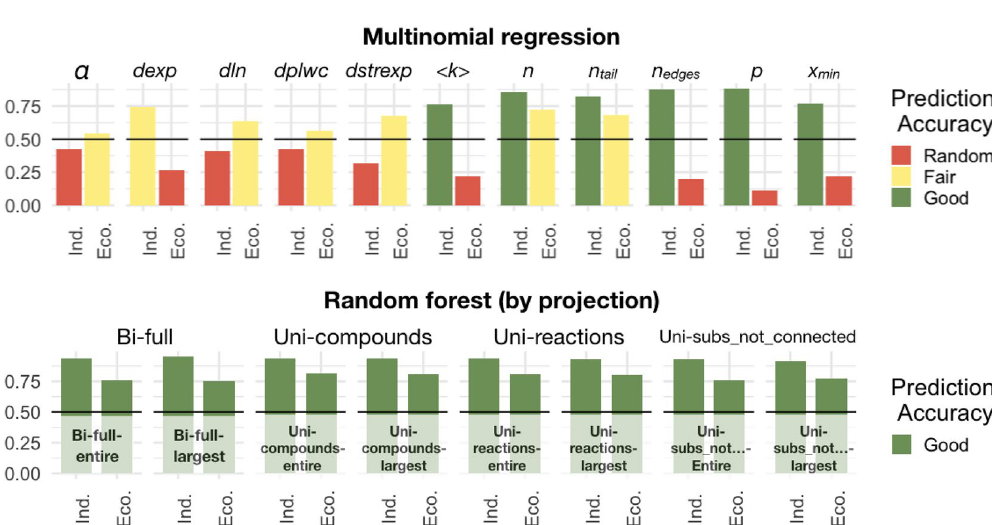
Figure 4. The distribution of p -values, tail-sizes, and power-law alpha values for biochemical network degree distributions, over all network projections. Left column The goodness-of-fit p -values of networks. When p (dashed line), it indicates that there is at least a 10% chance of the power-law distribution being a plausibly good fit to a network’s degree distribution. Center column Tail size of networks. When n tail line), it indicates that the tail of distribution is large enough to reliably fit. Right column Power-law exponent α values of networks. When 2 < α < 3 (between dashed lines), it indicates that a network meets the criteria of having a power-law exponent which falls into scale-free territory. The top row (in red) shows distributions for individuals. The bottom row (in blue) shows distributions for ecosystems. Insets indicate the number (and percent) of networks which meet the criteria, ± 2SD.